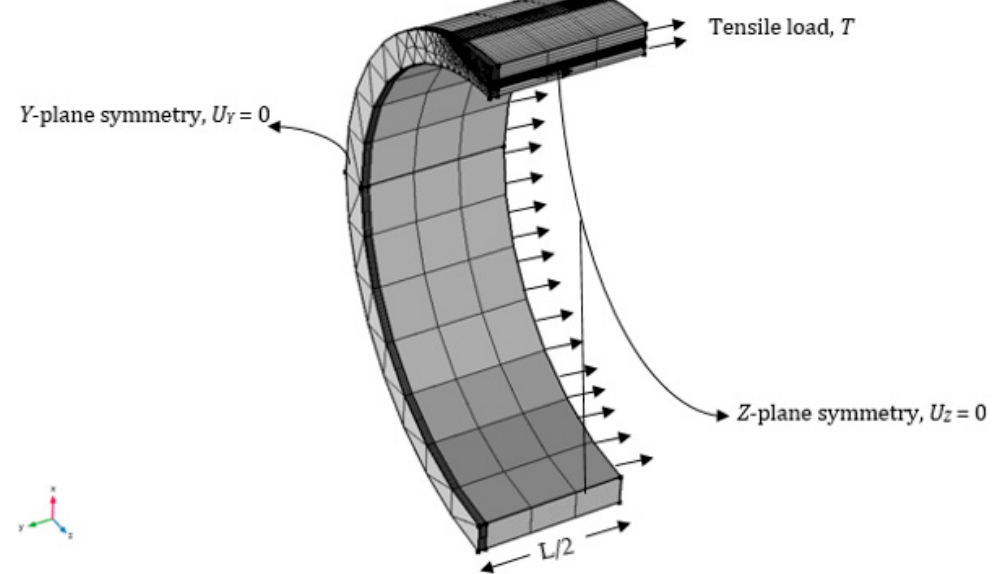
Figure 8. Applied boundary conditions and external tensile